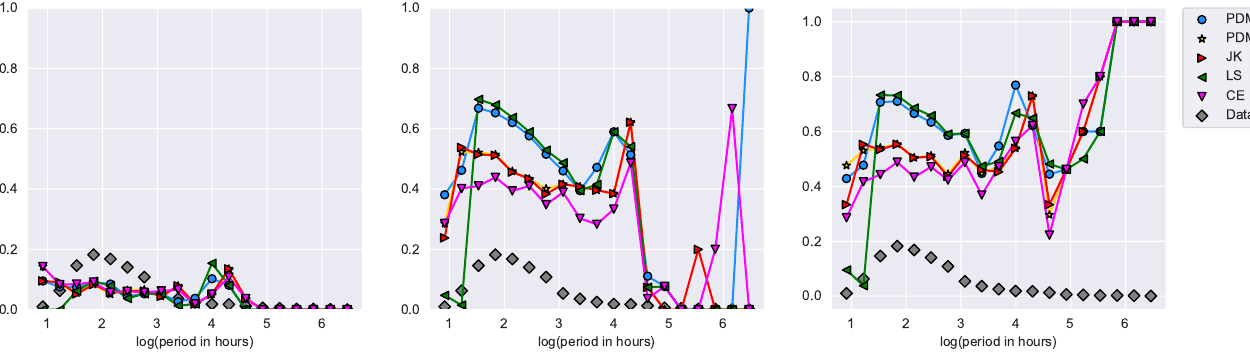
Figure 12. The comparison of different period finding algorithms considering the different reported periods for the step size of 10 − 5 h and the range of 2 h–40 h of period searching. The criterion for comparison is the proportion of asteroids having a successful periodic recovery. From left to right, the three plots are for different δφ max = 85/50,850/50 and 8500/50. The gray diamonds indicate the proportion of asteroids at the corresponding reported period in our data